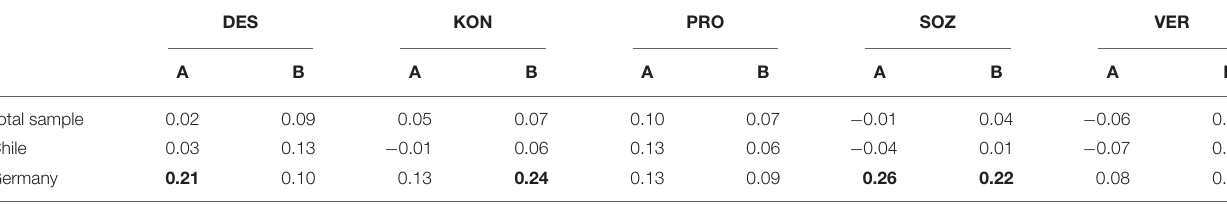
TABLE 2 | Coefficients for Q3 statistic for the total sample by country and subscale. DES KON PRO SOZ VER